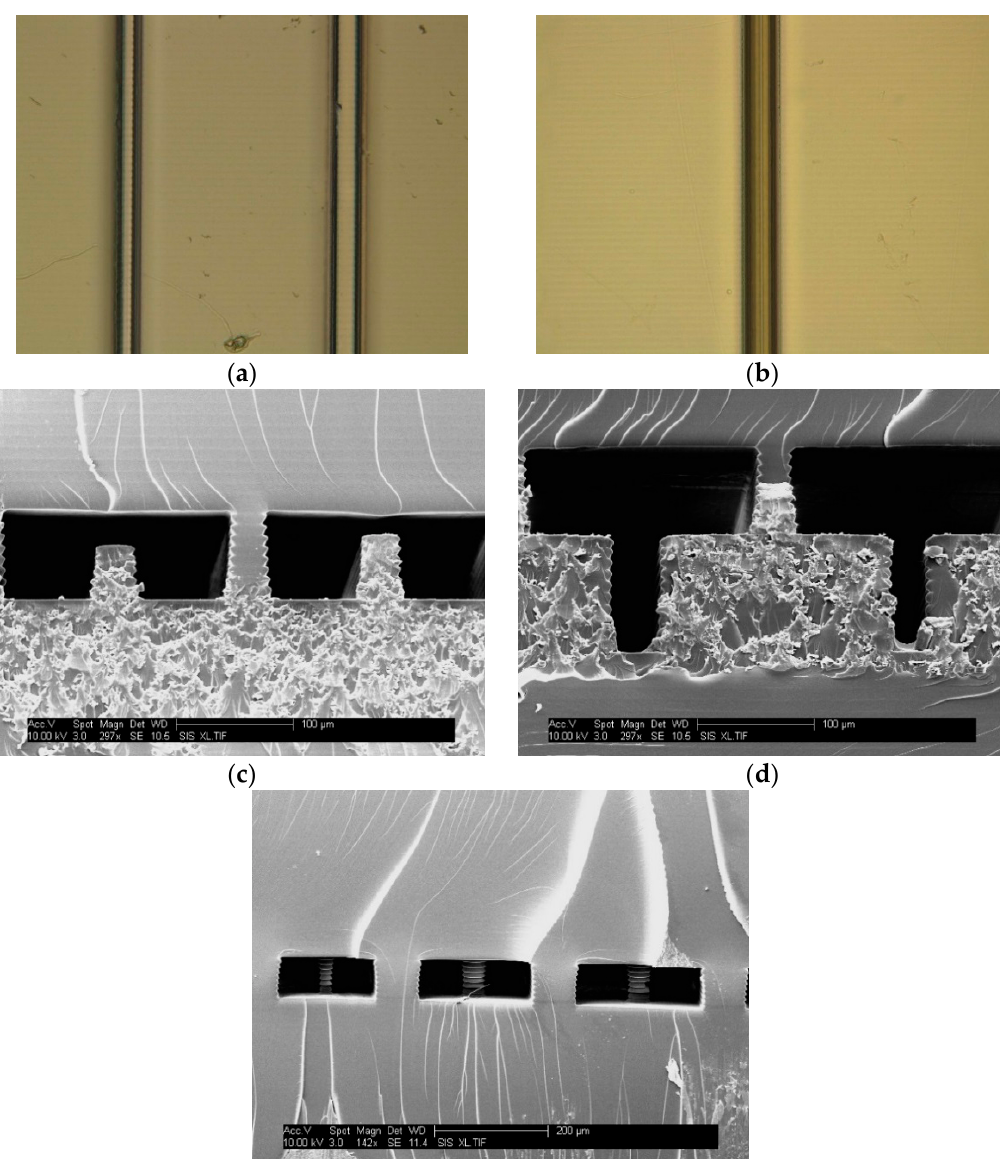
Figure 2. Images of 3D printed features. ( a ) Top view photograph of 1500 ms exposure ridges designed 3 and 4 pixels (23 and 30 μ m) wide. The ridges measured 25 ± 1 and 29 ± 1 μ m; ( b ) Top view photograph of a 500 ms exposure (without compensation) trench designed 4 pixels (30 μ m) wide, which measures 21 ± 0.5 μ m; ( c ) SEM images of 1000 ms exposure interior ridges designed 5 and 6 layers tall. The ridges measured 46 ± 1 and 55 ± 1 µ m tall, respectively; a support pillar is in the middle of the image; ( d ) SEM image of interior trenches at 1000 ms exposure without compensation designed 5 and 6 pixels (38 and 46 µ m) wide, which measured 22 ± 0.7 and 34 ± 2 µ m wide; ( e ) SEM image of interior pillar structures at 1500 ms exposure designed to be 5–7 pixels (38–53 µ m) in diameter.